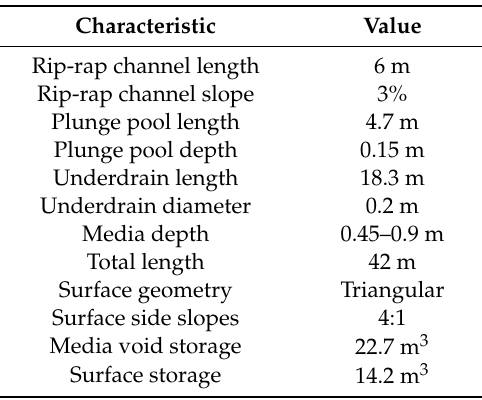
Figure 3. Bioswale longitudinal cross-section [47]. Table 2. Bioswale design characteristics [47].